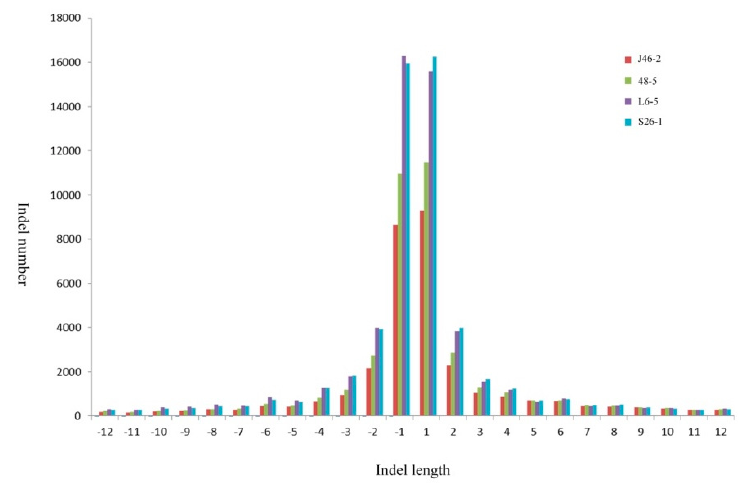
Figure 3. Genome-wide analyses the proportions of indels mutations in the four ethyl methanesulfonate -induced eggplant mutants.